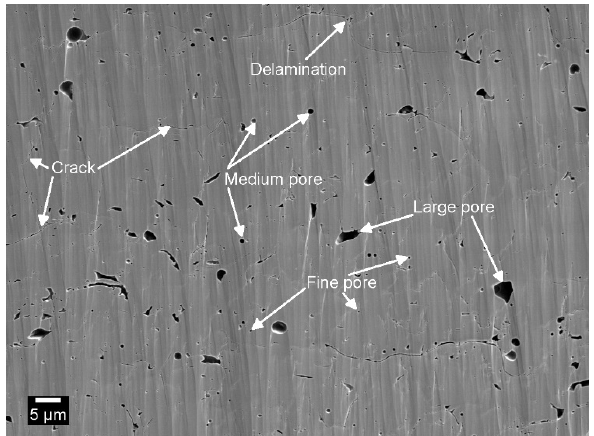
Figure 2. Cross-sectional SEM image showing the shapes and relative sizes (area) of pores and cracks; fine: < 1 µ m 2 ; medium: 1 to 10 µ m 2 ; and large: > 10 µ m 2 .